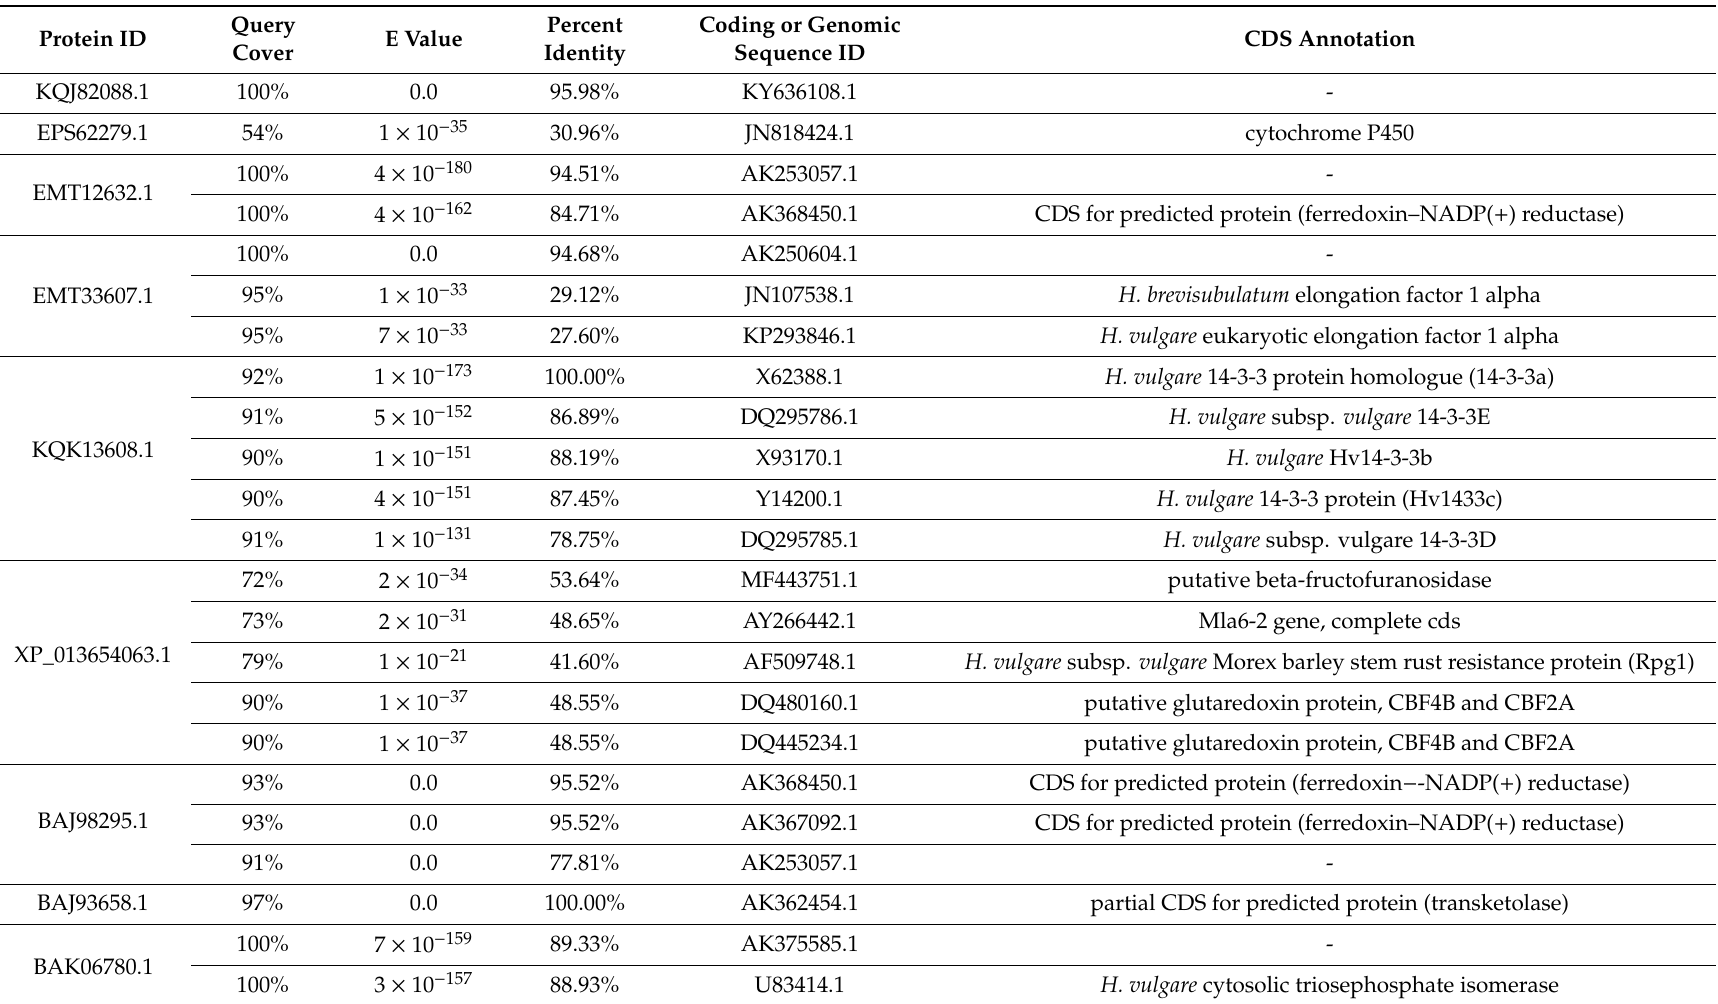
Table 1. Coding sequences (CDS) obtained through tblastn analysis for selected protein